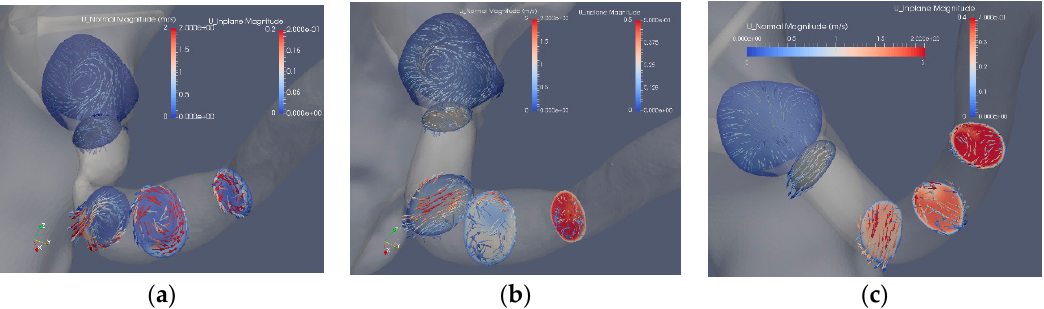
Figure 6. The axial and in-plane velocity components: stenosis (Case1.1) ( a ), Voronoi reconstructed (Case1.2) ( b ) and reconstructed with mesh sweeps (Case1.3) ( c ). Note that the scales of the axial components differ from the in-plane components.